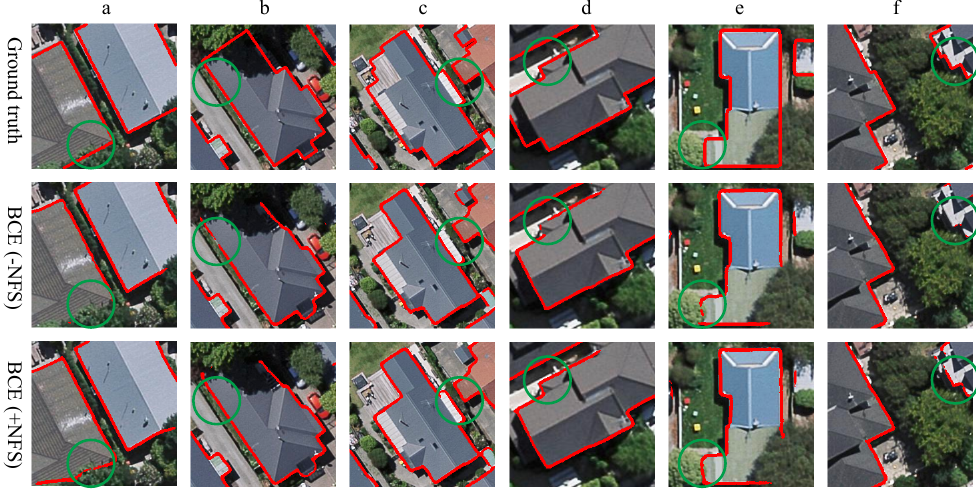
Figure 11. Representative results of outlines extracted from model trained by binary cross-entropy (BCE) loss with/without nearest feature selector (NFS). Backgrounds, red lines, and green circles represent aerial input, predicted outline, and focused area, respectively.Selected results are denoted as ( a – f